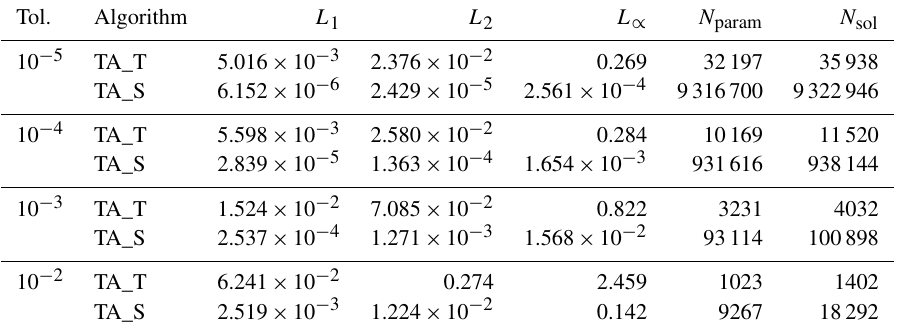
Table 4. Relative errors and number of iterations obtained for the time-adaptive algorithm depending on different convergence criteria for TC1.